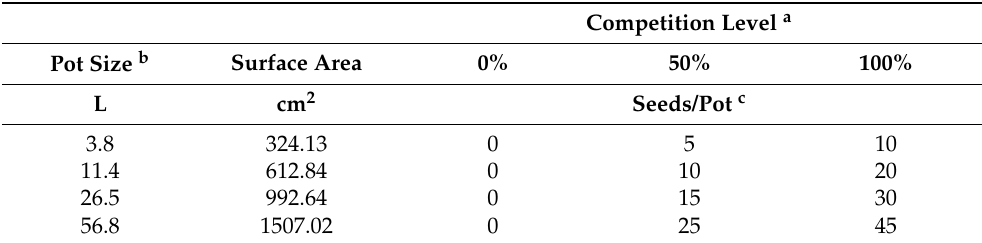
Table 1. Substrate surface area and weed seeds sown in 3.8, 11.4, 26.5, and 56.8 L nursery pots to maintain 0%, 50%, or 100% weed coverage